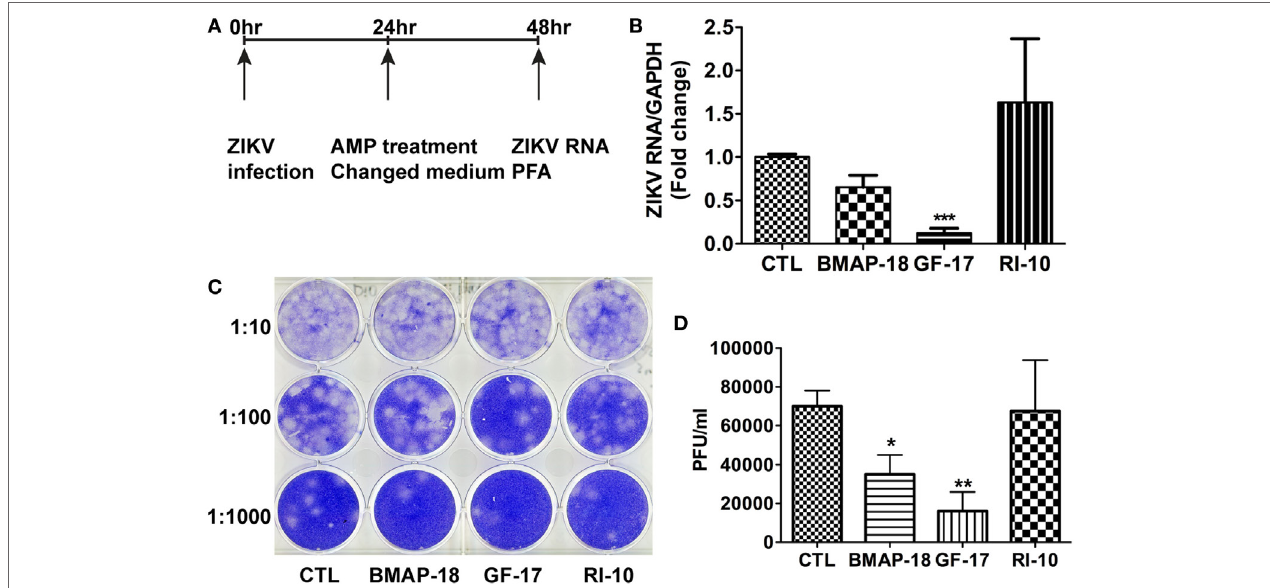
FigUre 4 | Antimicrobial peptides treatment post-infection is still effective in inhibiting Zika virus (ZIKV) infection. (a) Primary human fetal astrocytes were infected with ZIKV at the MOI of 0.5 for 24 h before antimicrobial peptide treatment at 10 µM. (B–D) At 24-h post-antimicrobial peptide treatment, RNA was isolated from cells and ZIKV RNA was determined through real-time RT-PCR. Data were normalized to GAPDH and presented as fold change compared with ZIKV group (B) . Cell-free supernatants were collected and subjected to PFA for determination of viral titer (c,D) . CTL, control. * p < 0.05, ** p < 0.01, and *** p < 0.001 as compared with the ZIKV group without peptide treatment (ANOVA, N =